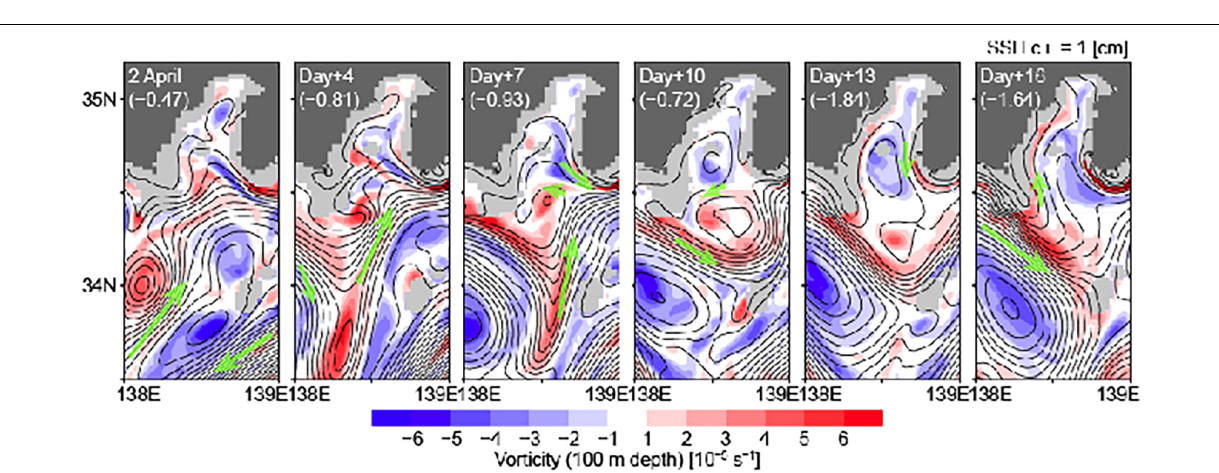
FIGURE 11 | Distributions of SSHs (contours with 1 cm intervals) and relative vorticities at 100 m depth (shading) during a negative EOF1 event starting from 2 April 2017 ( left to right ). Days from 2 April and the EOF1 time coefficient are indicated in each figure. Broad flow directions are indicated by green